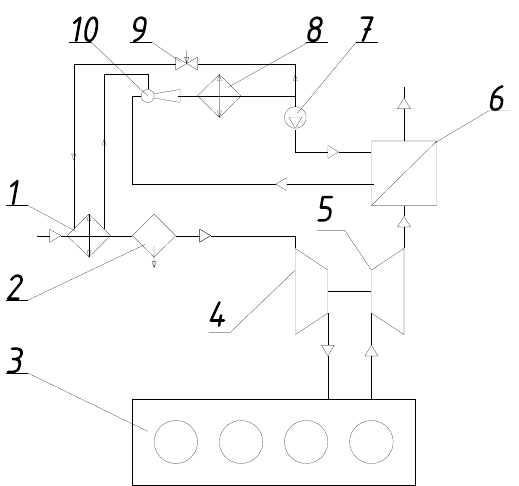
Figure 13. Waste heat absorption refrigerator for intake air cooling: 1—evaporating air cooler; 2—condensate drain; 3—engine; 4—compressor; 5—turbine; 6—exhaust gas boiler; 7—pump; 8—working fluid condenser; 9—throttle valve; 10—ejector. Source: developed by authors.